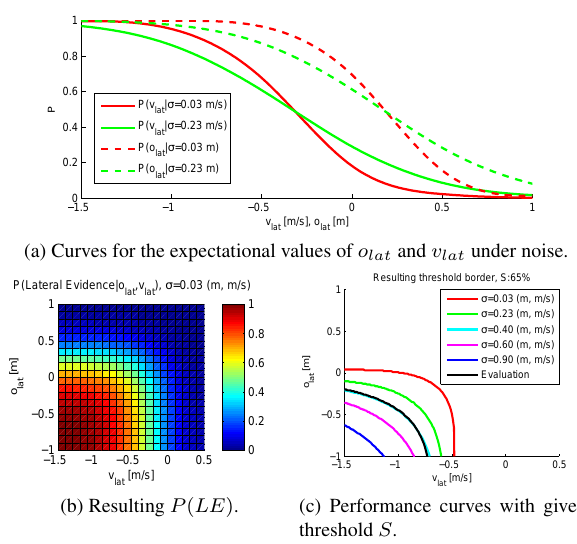
Figure 10: Probability under the presence of noise and resulting performance with given